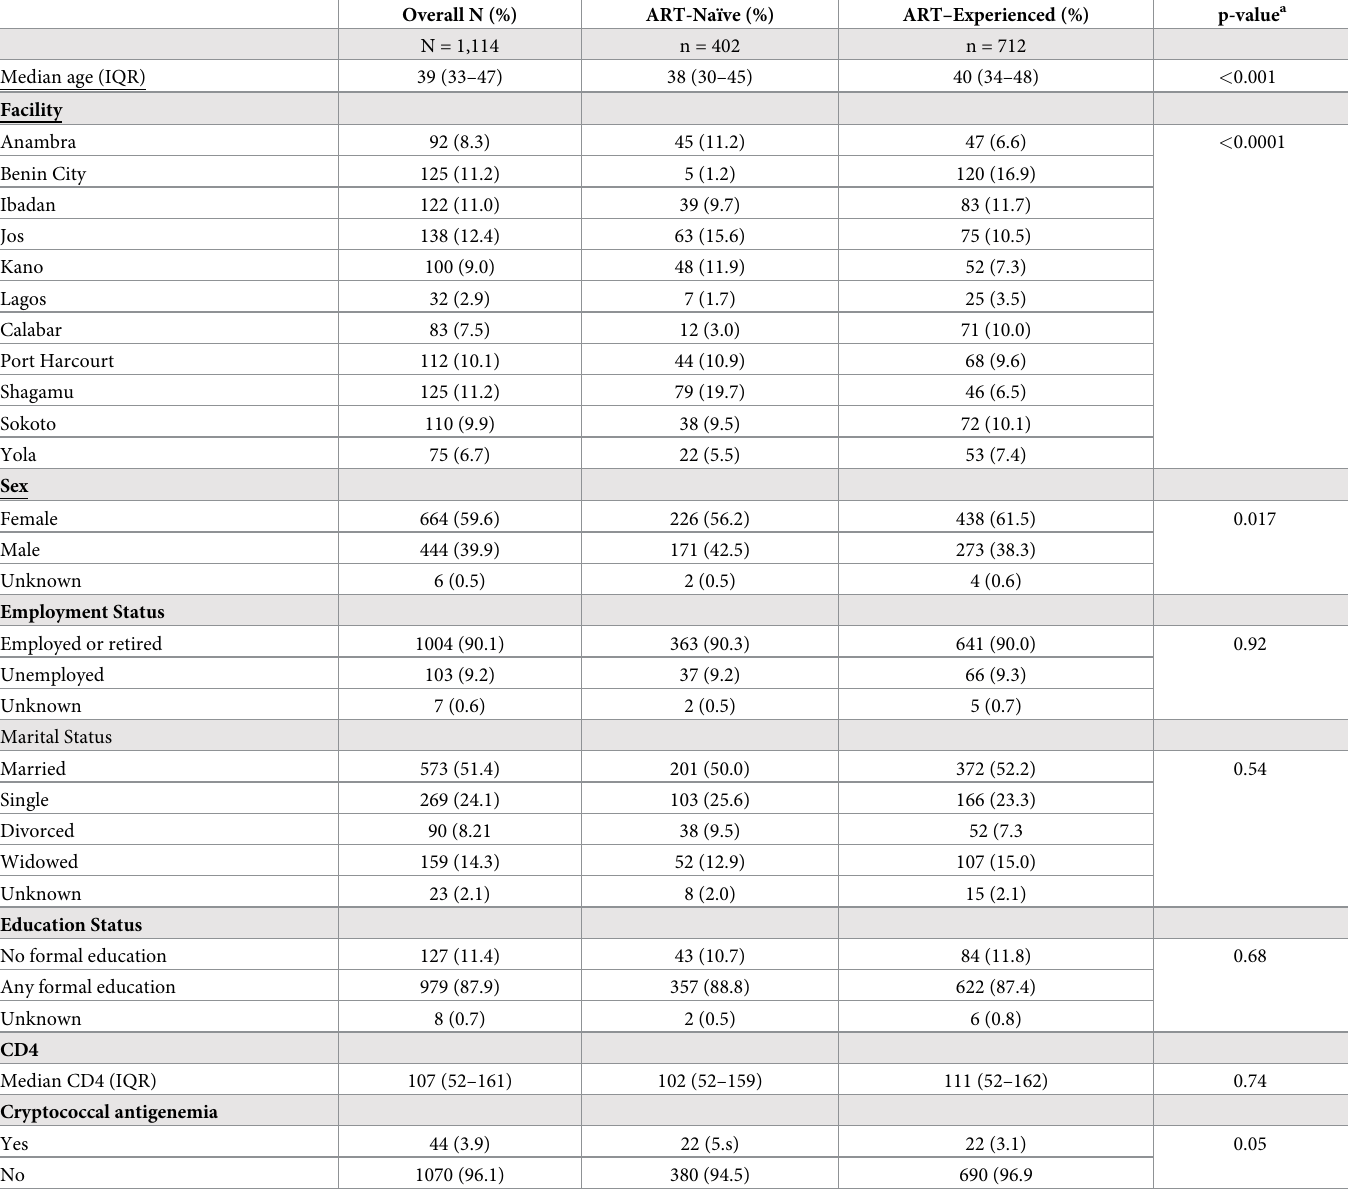
Table 1. Demographic and clinical variables of patients screened for